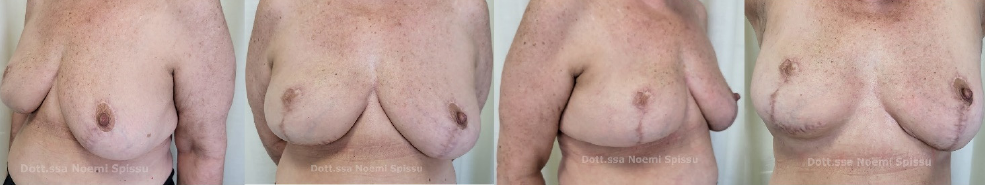
Figure 5. Clinical result at three months of follow-up. The patient was treated with type IV nipple- sparing mastectomy on the right side with submuscular reconstruction (460 cc implants) and con- comitant contralateral reduction mammoplasty.